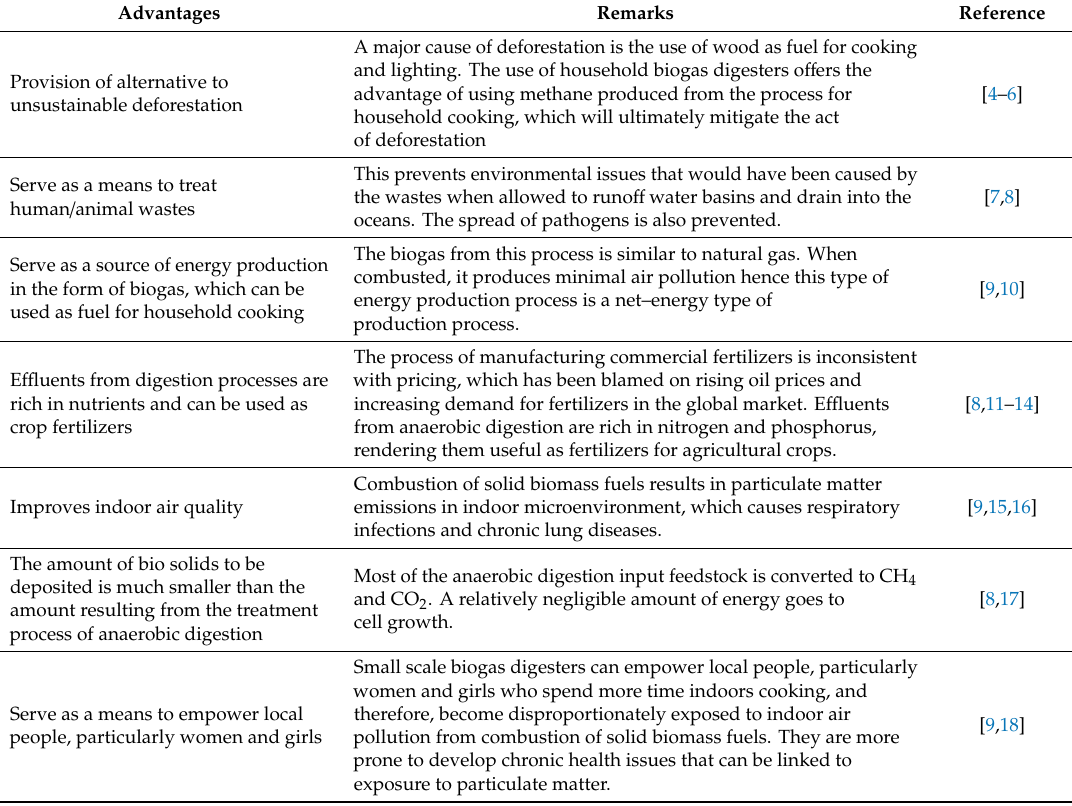
Table 1. A summary of the major advantages of the use of anaerobic digestion